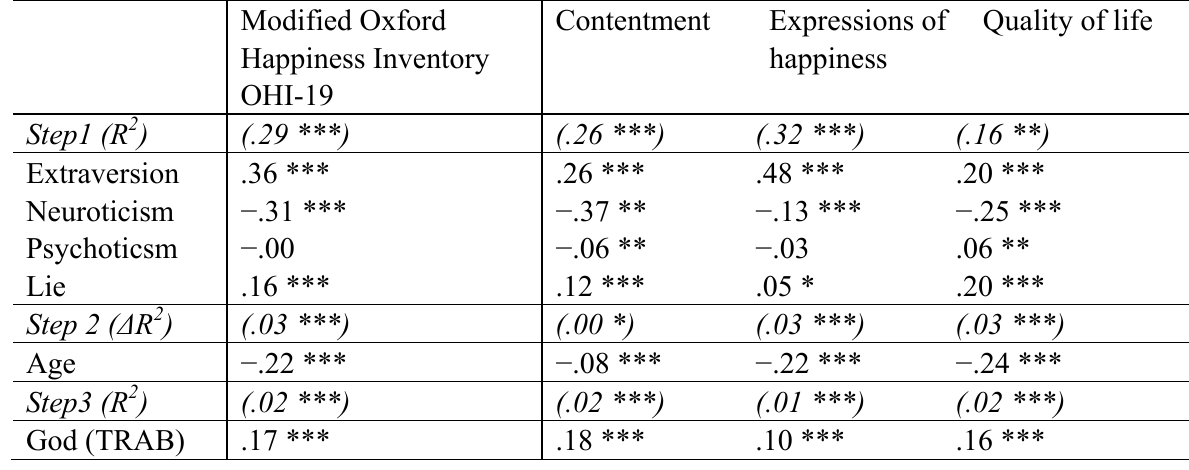
Table 2. Results of hierarchical regression analyses of happiness among university and religious secondary school students and church-attenders, by personality (step 1), age (step 2), relationship with God (step 3) (standardized beta and R 2 values shown). Modified Oxford Contentment Expressions of OHI-19